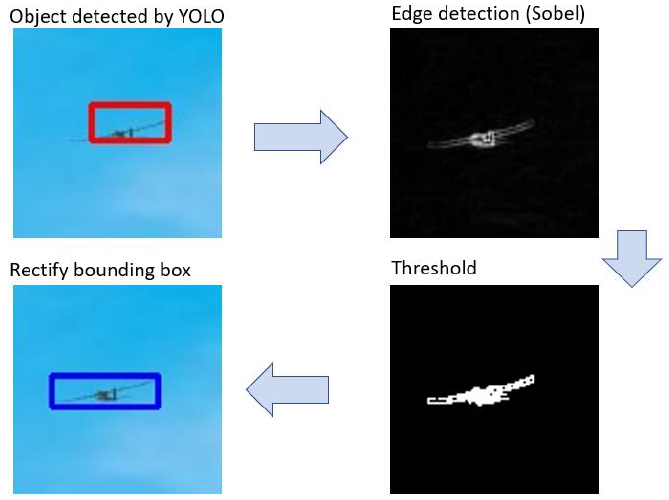
Figure 15. Process to rectify the bounding box given by the YOLOv3 detector.